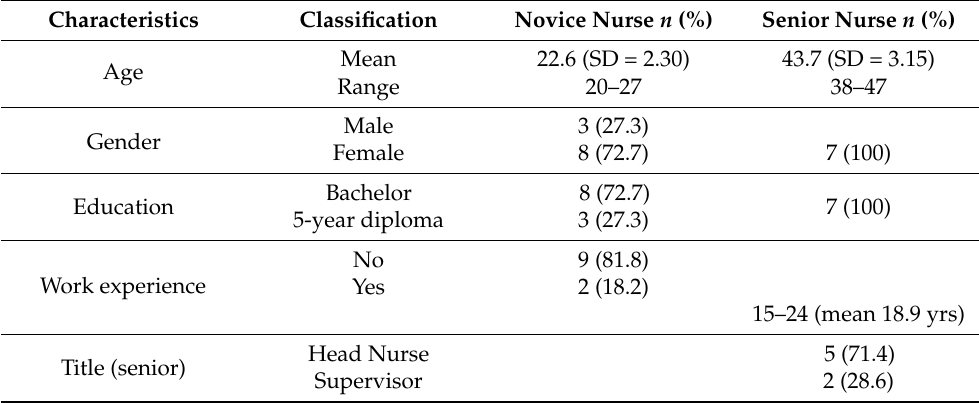
Table 2. Participant characteristics n = 11 (novice nurse) and 7 (senior nurse). Characteristics